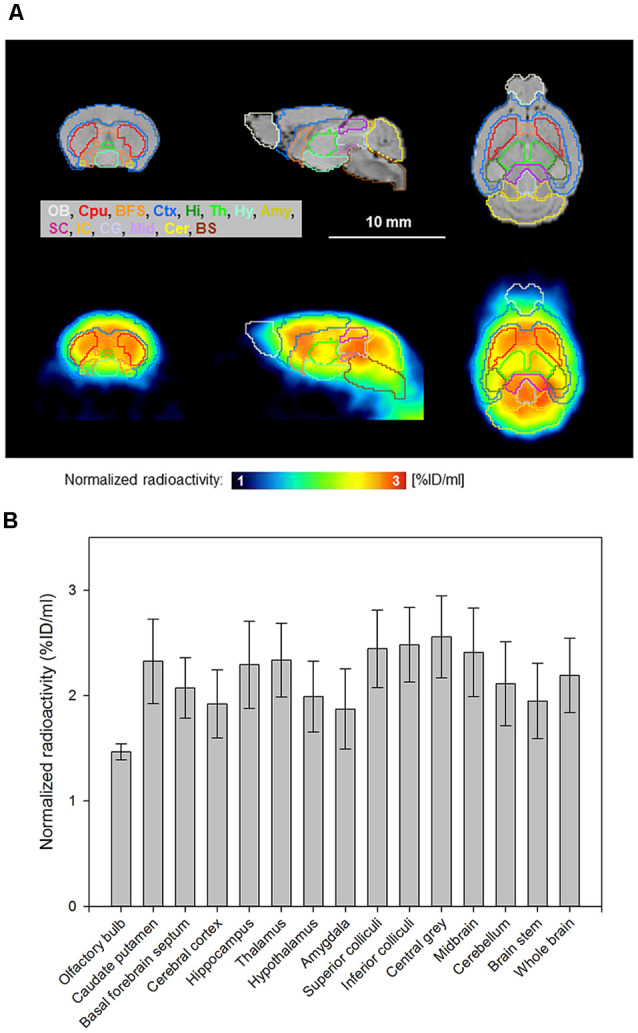
[18F]MK-9470 accumulation in the mouse brain as measured with PET. PET images were summed from 40 to 60 min and co-registered to a T2-weighted magnetic resonance template (PMOD Technologies LLC, Zurich, Switzerland). The radioactivity concentration of the ligand in tissue was normalized to the injected radioactivity for each mouse and averaged over the entire group (n = 5; injected radioactivity: 6.6 ± 1.1 MBq, anesthesia: 2% isoflurane, data acquisition: 60 min). (A) Horizontal brain layers of magnetic resonance images (MRI) and PET images are passing through the interaural line from 6 to 0 mm. T2-weighted magnetic resonance template images are presented as anatomic reference. (B) Region-specific accumulation of [18F]MK-9470 in the mouse brain as obtained from standardized VOIs (PMOD Technologies LLC, Zurich, Switzerland). Results are presented as mean ± standard deviation.